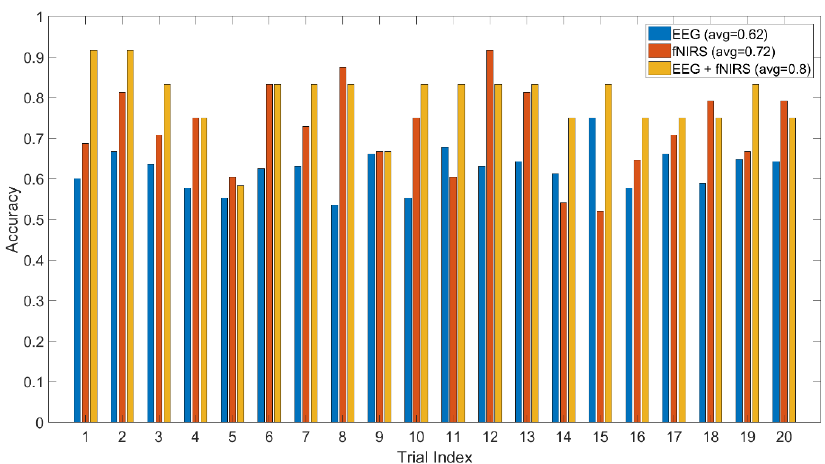
Figure 10. Comparison of the proposed method (EEG + fNIRS) and the ones where only EEG or fNIRS employed for all image-content trials.